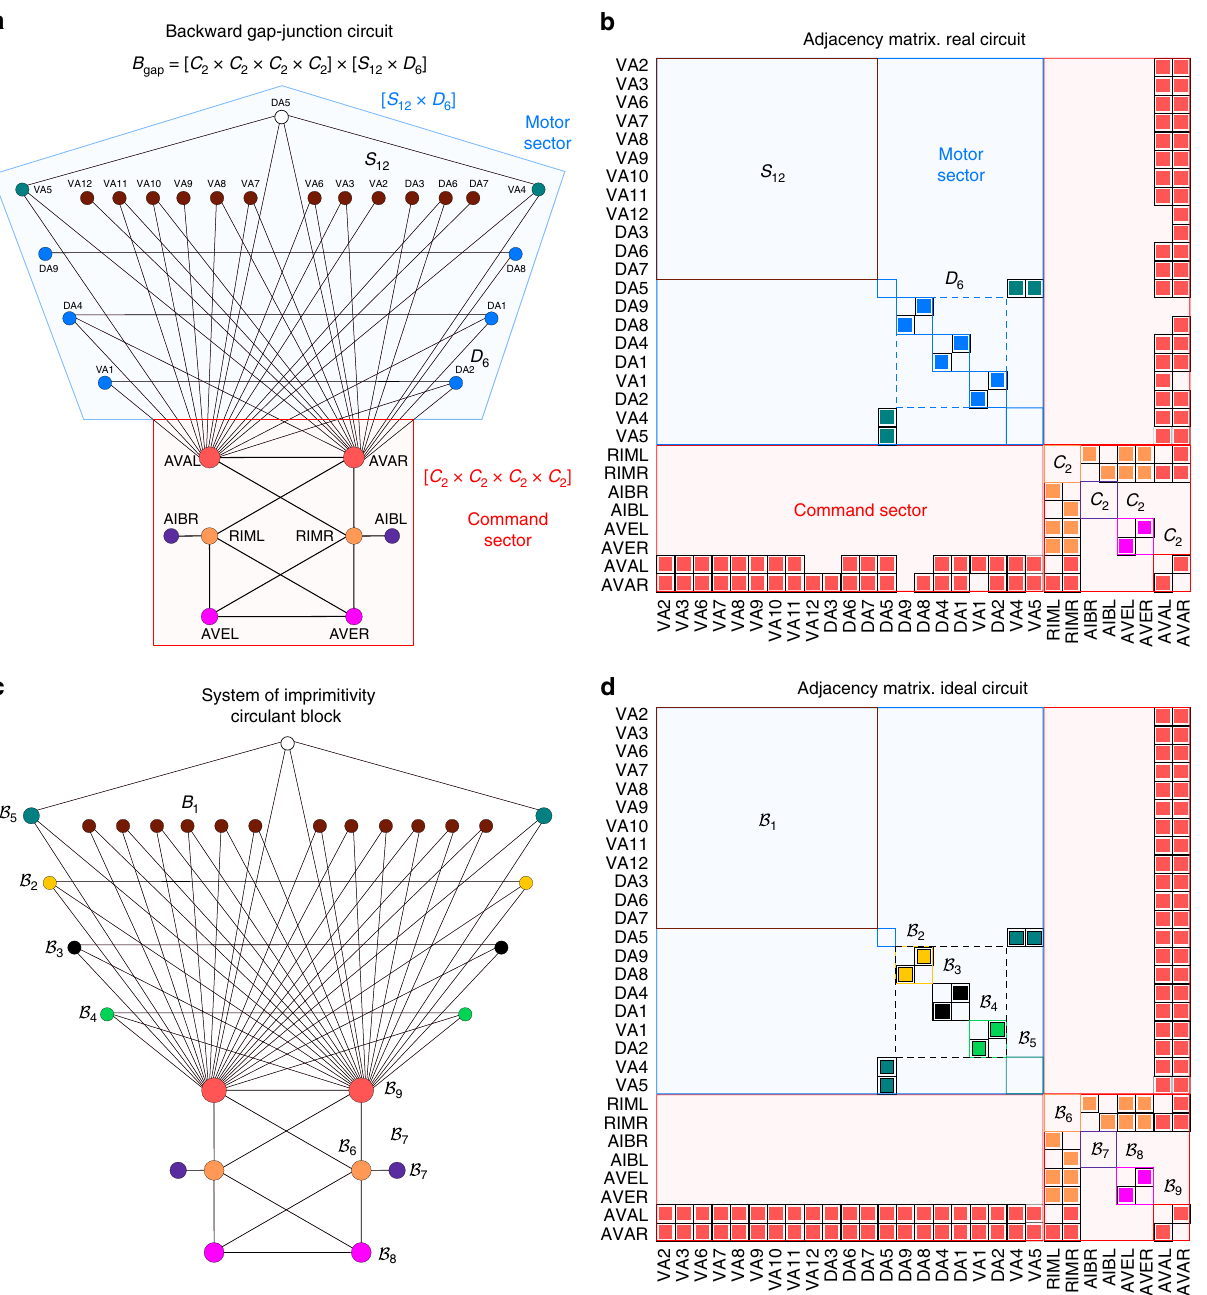
of the backward gap-junction circuit. a The real circuits and ( b ) its adjacency matrix. The symmetry group is factorized as a gap ¼ ½ C ´ C ´ D (cid:3) ´ ½ S ´ D ´ C (cid:3) , which leads to a partition of neurons in two sectors that match the command gap 2 2 1 12 6 2